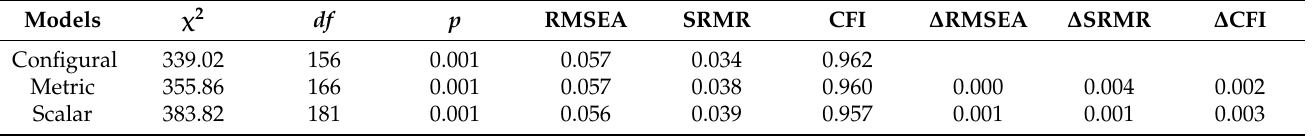
Table 3. Gender Measurement Invariance of Multidimensional Prayer